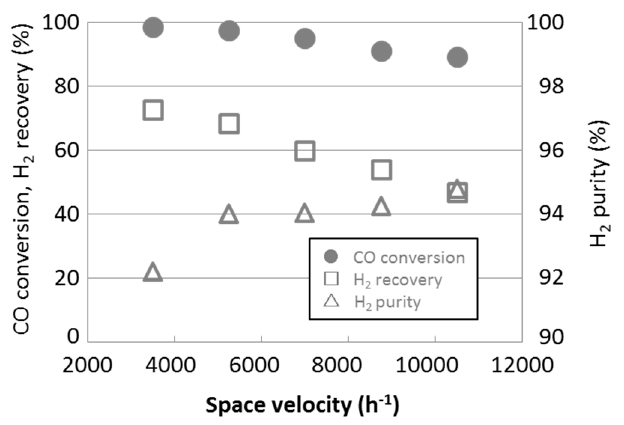
Figure 13. Water gas shift reaction with various space velocities (SVs).